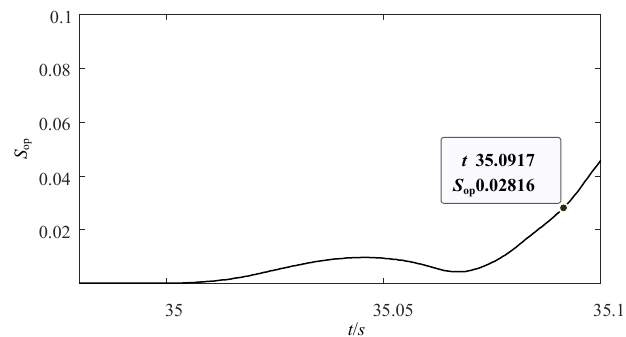
Figure 7. The action of the protection when the slip ratio s is 0.05.